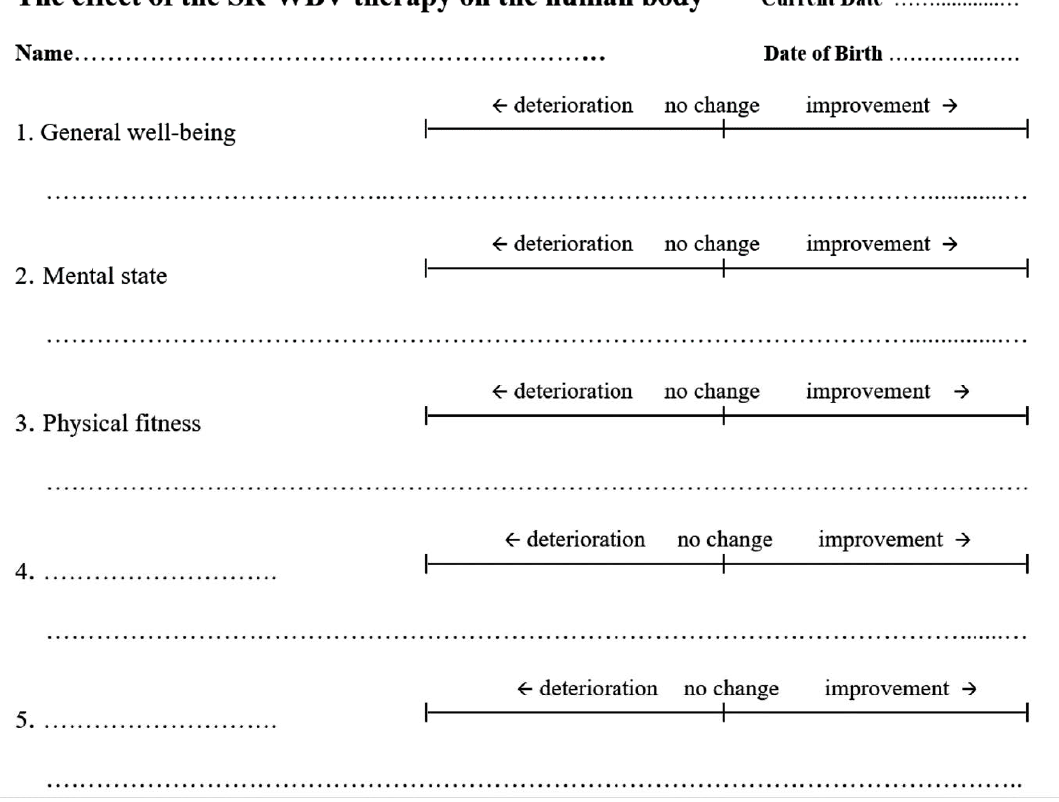
Figure 3. Questionnaire: The effect of SR-WBV therapy on the human body. Appl. Sci. 2021 , 11 , 3980